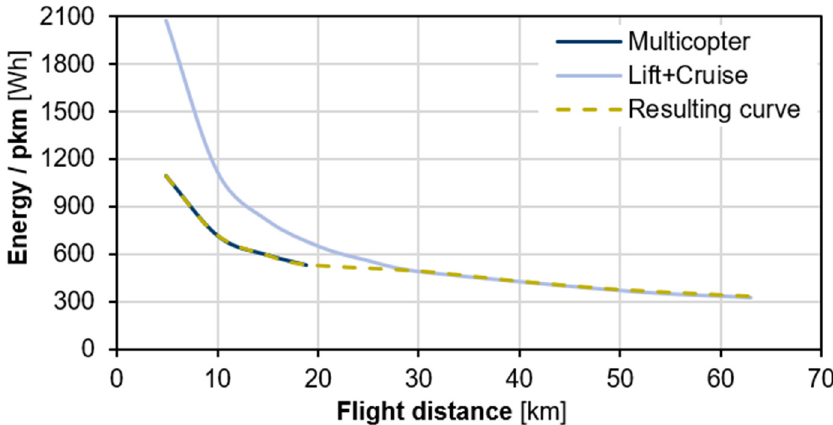
Figure 9. Passenger unmanned aviation energy demand for unmanned aviation with a maximum capacity of four passengers